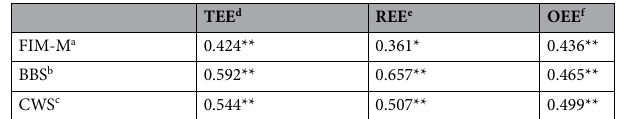
Table 3. Correlation coefficient between physical function and energy expenditure. **p < 0.01, *p < 0.05. a Functional Independence Measure Motor score. b Berg Balance Scale. c 10-m comfortable walking speed. d Total energy expenditure per day. e Energy expenditure during rehabilitation. f Energy expenditure other than during